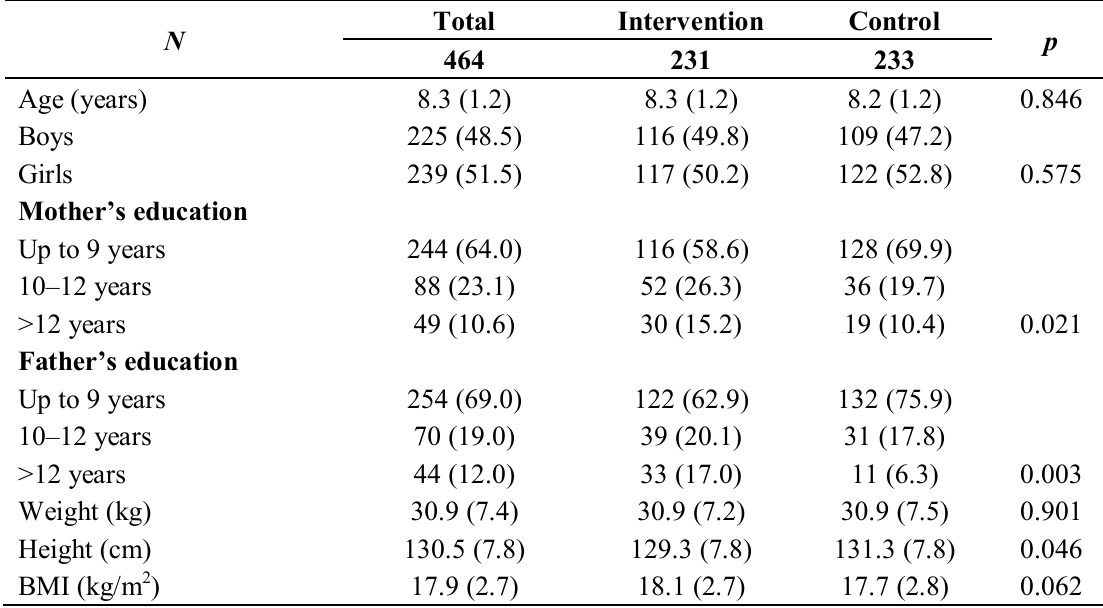
Table 1. Characteristics of the sample at baseline in intervention and control schools.